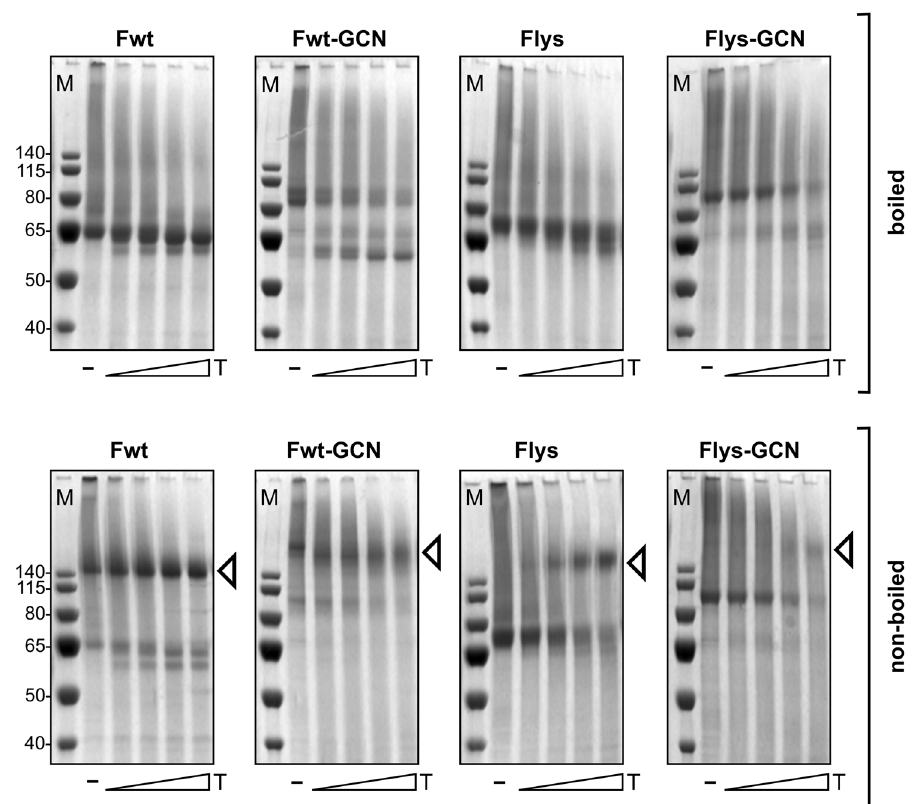
Figure 3. Trypsin proteolysis of recombinant F proteins. Purified F proteins were mock treated ( 2 ) or treated with increasing amounts of TPCK-Trypsin (T; increasing amounts indicated by the triangles). F proteins were subsequently analyzed by SDS-PAGE using non-reducing conditions, with (top panels) or without (bottom panels) prior boiling of the samples and stained using colloidal blue. Fwt-GCN and Flys-GCN contain a C- terminal LysM domain and ST3 tag. Fwt and Flys contain a C-terminal ST3 tag. The size of the molecular mass markers (in kDa) is shown on the left of each panel (M). Arrowheads indicate the positions in the gel of the SDS-resistant higher-order structures that are only observed when the samples were not heated prior to electrophoresis.